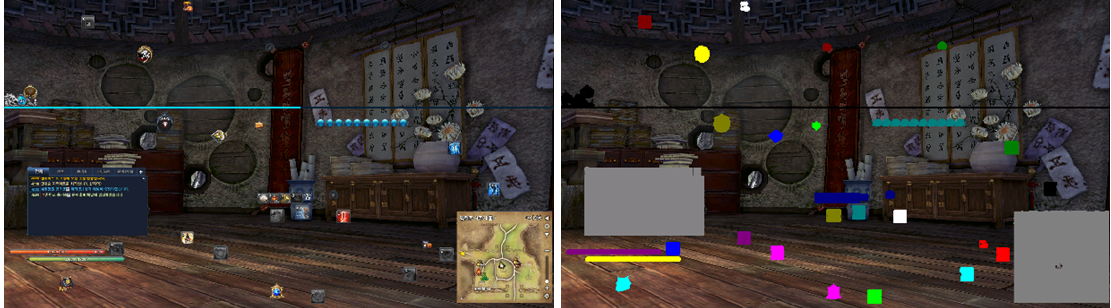
Figure 3. Paired synthetic UI